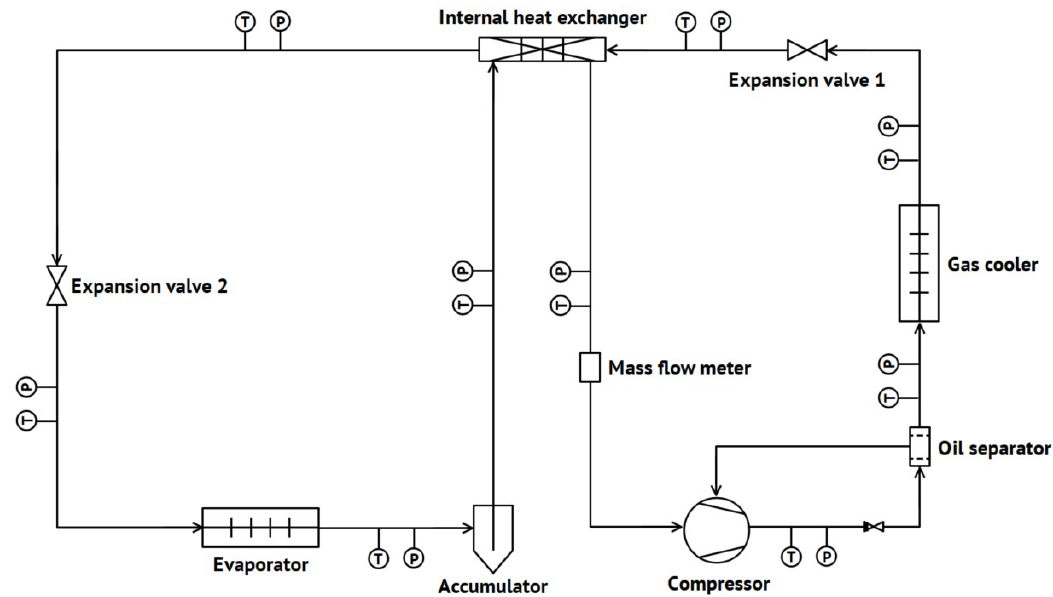
Figure 1. Scheme of the considered CO 2 air conditioning system. Table 1. On-design specifications of the gas cooler.